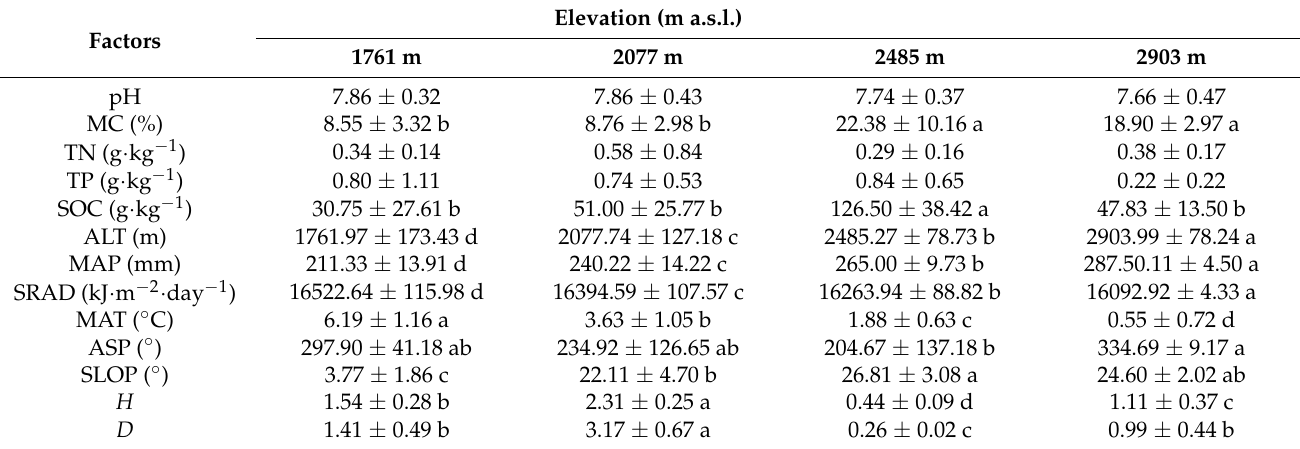
Table 1. Soil physiochemical properties and environmental factors along the elevation